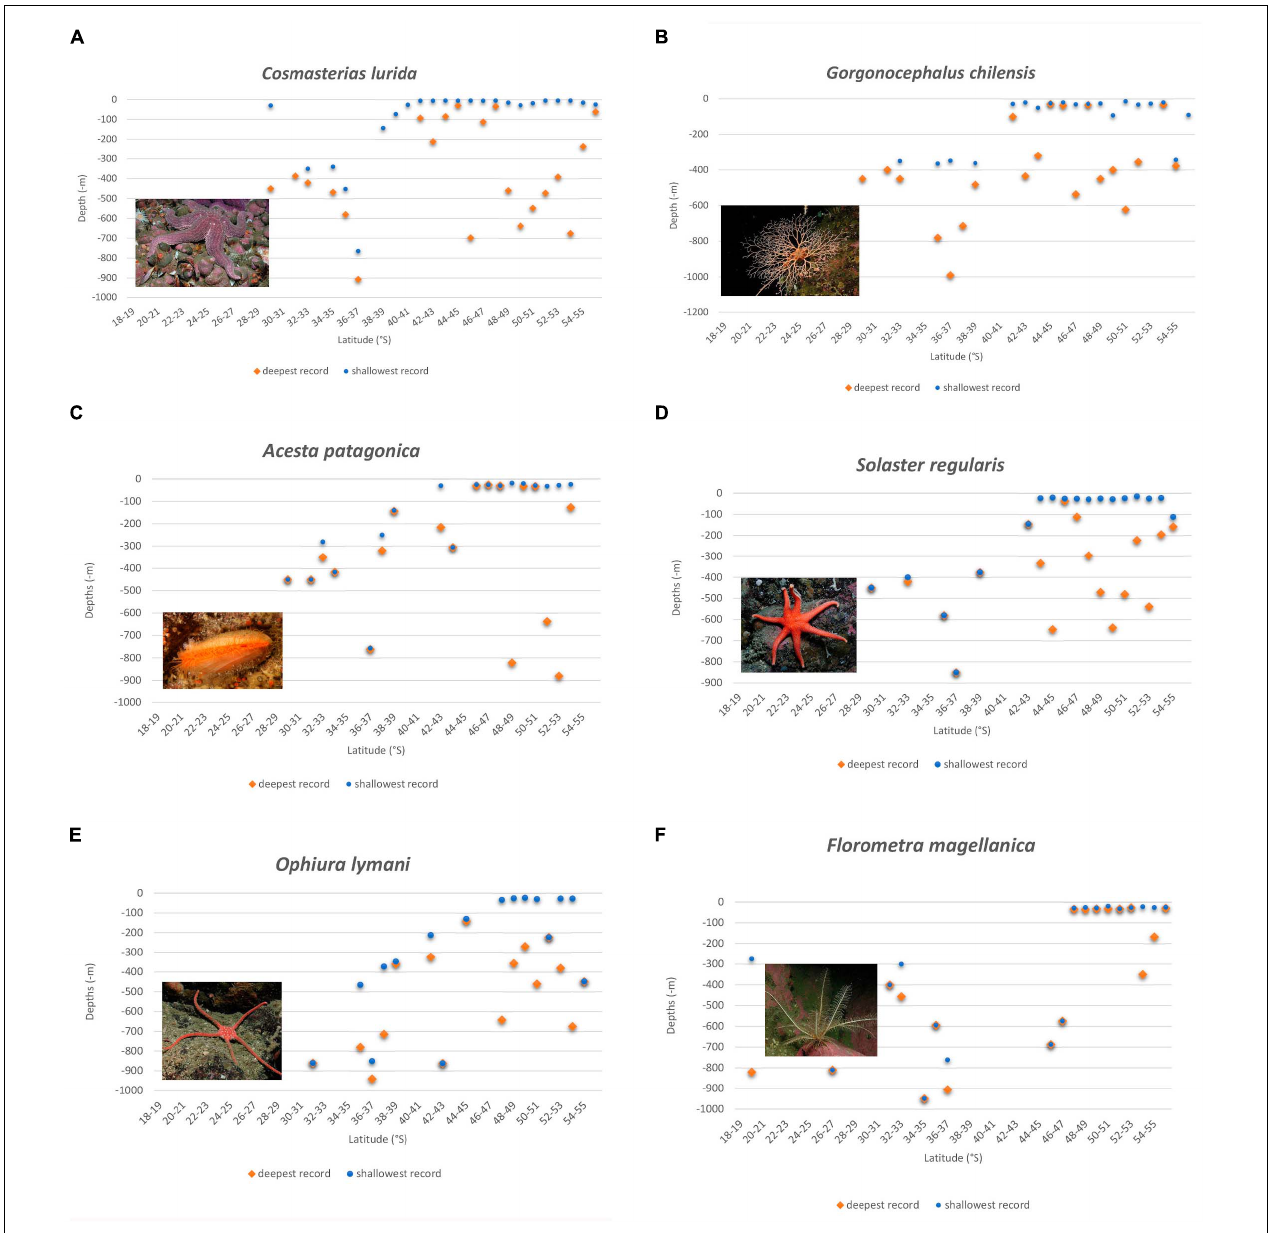
FIGURE 2 | Depth distribution of six typical deep-water emergent species with above-average number of records throughout Chile and appearance in shallow water of North Patagonia (A–D) and Central Patagonia (E–F) , sorted by appearance from north to south. A trend is visible with the upper depth distribution limit (deep-water emergence phenomenon) rising toward the south. (A) Cosmasterias lurida (Asteroidea), (B) Gorgonocephalus chilensis (Ophiuroidea), (C) Acesta patagonica (Bivalvia); (D) Solaster regularis (Asteroidea); (E) Ophiura lymani (Ophiuroidea); (F) Florometra magellanica (Crinoidea).